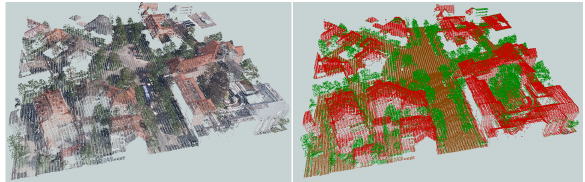
Figure 1. Colored point cloud (left) and classified point cloud (right); brown=ground, red=building,